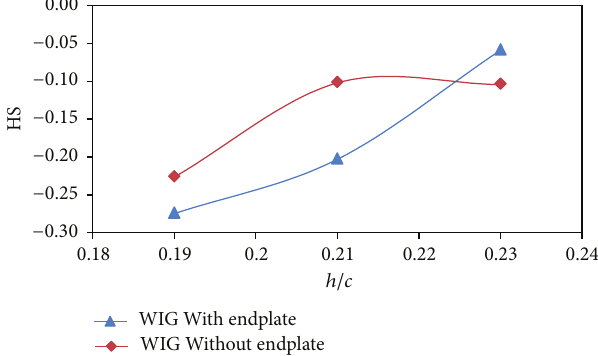
Figure 13: Height of static stability (HS) of WIG craft model with and without endplates versus ground clearance ( ℎ/𝑐 ) at angle of attack of 4 ∘